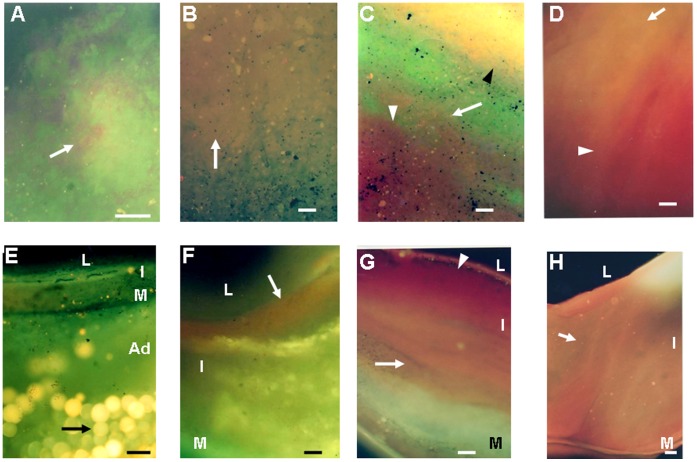
Deposition Patterns of Low-density Lipoprotein (LDL) in Coronary Arteries. Upper Column.Scanning of the luminal surface by CFM after administration of NB, showing (A) spotty type deposition of LDL (arrow), (B) diffuse type deposition of LDL (arrow), (C) separated co-deposition of LDL (arrow) with ApoB-100 (black arrowhead) and other lipid components that exhibited red fluorescence such as LPC, TG and ApoE-2 (white arrowhead), and (D) overlapping co-deposition of LDL (arrow) and “R” (arrowhead), respectively. Lower Column. Scanning of the transected surface by CFM after administration of NB showed (E) no deposition of LDL, but deposition of ApoB-100 in adipocytes (arrow), (F) deposition of LDL in the superficial layer of the intima (arrow), (G) deposition of LDL in the deep layer (arrow) with co-deposition of “R” in superficial layer (arrowhead), and (H) diffuse deposition of LDL in both layers (arrow). Bars = 100-µm.